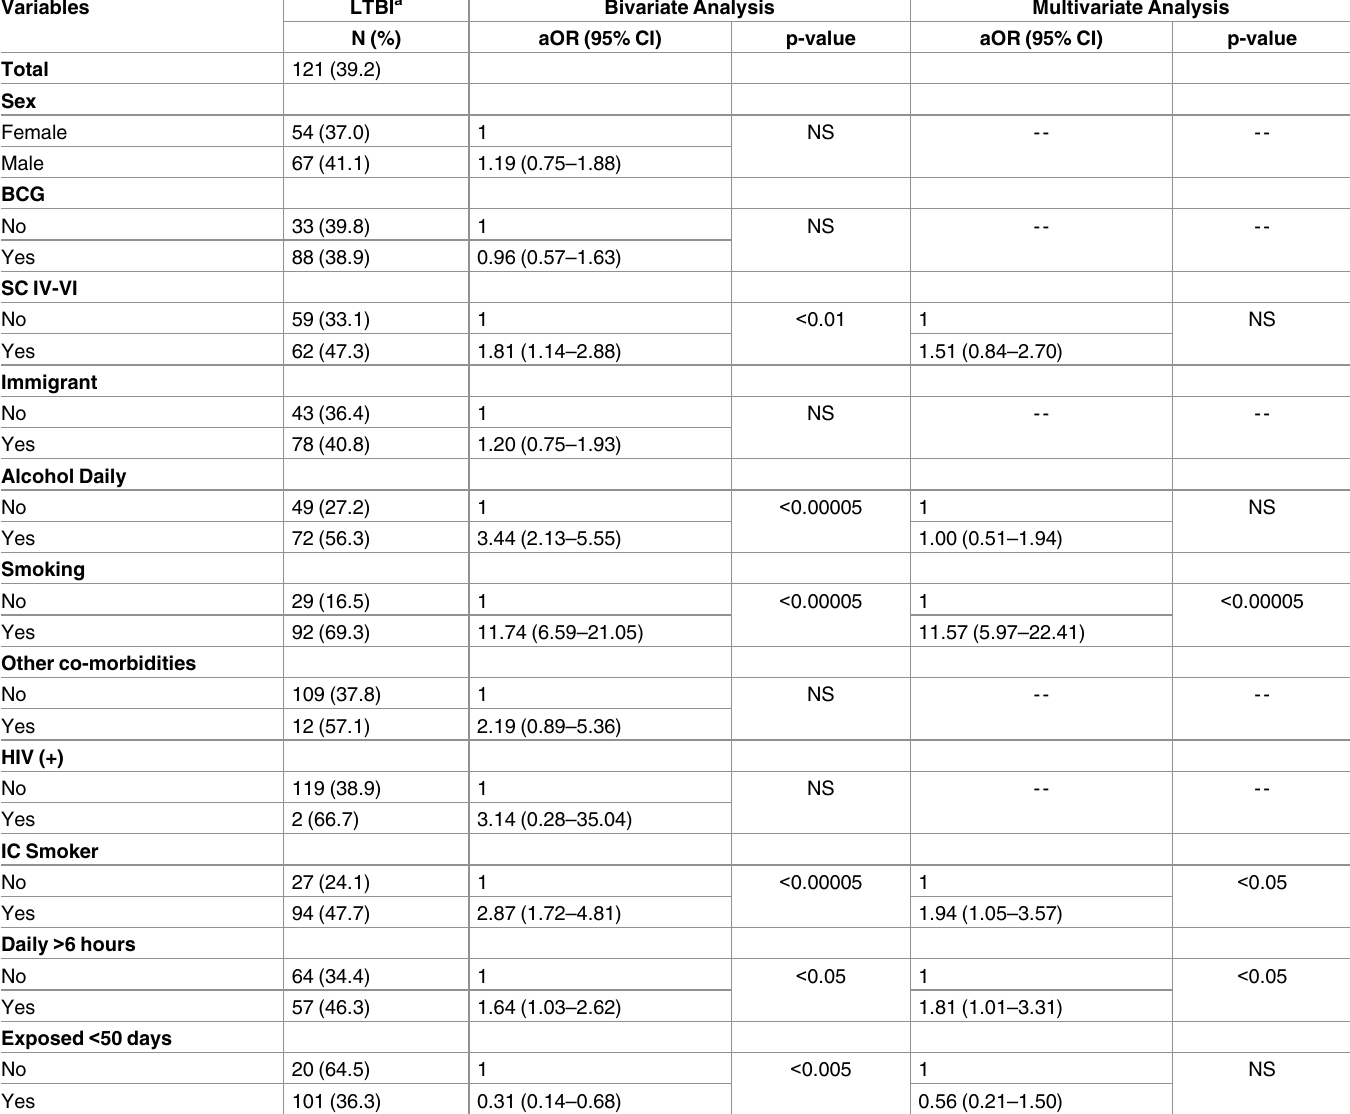
Table 5. LTBI risk factors analysed by bivariate and multivariate